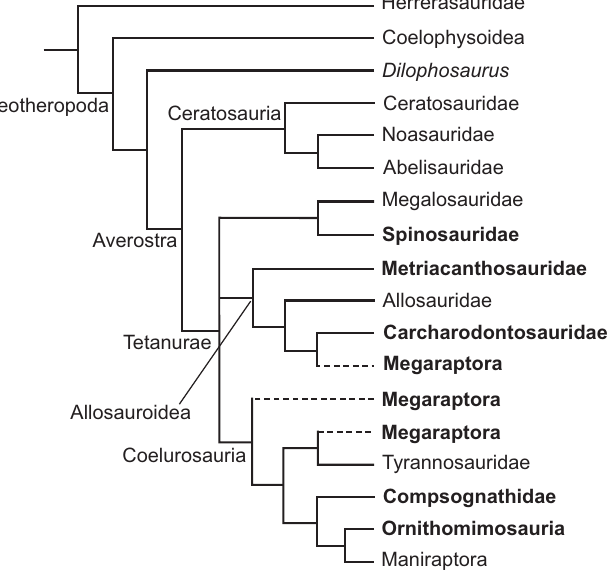
Fig. 1. Three hypotheses of the phylogenetic position of Megaraptora. Megaraptora as derived Carcharodontosauria (Benson et al. 2010; Carrano et al. 2012); basal Coelurosauria (Novas et al. 2015; Apestiguea et al. 2016; Delcourt and Grillo 2018); and basal Tyrannosauroidea (Novas et al. 2012a, 2013; Porfiri et al. 2014; Cau 2018). The tree is modified from Ezcurra and Novas (2016). Bolded are theropods found in